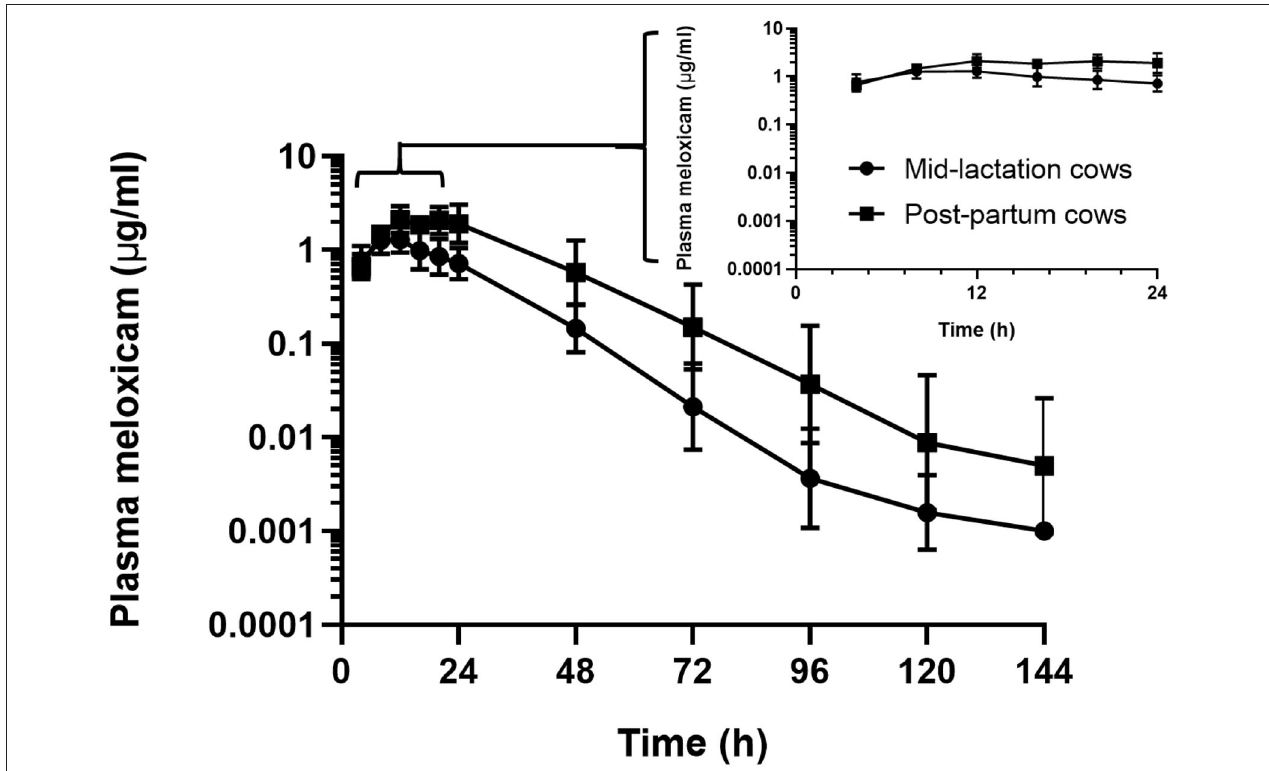
FIGURE 2 | Semilogarithmic transformation of geometric mean plasma concentration (with 95% confidence interval) for post-partum ( n = 6) and mid-lactation ( n = 6) cows that received a single dose of oral meloxicam at 1.0 mg/kg. Inset contains first 24h after meloxicam administration.